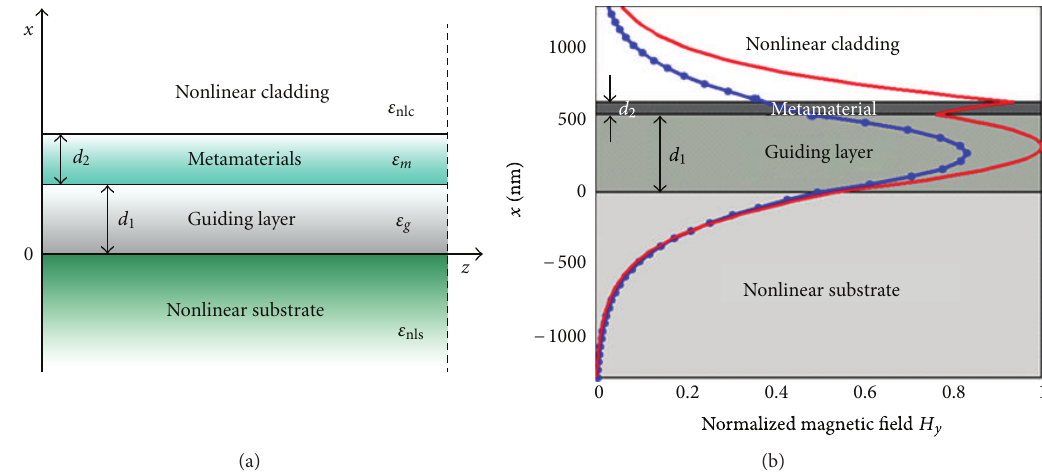
Figure 3: (a) Schematic diagram of a cross-sectional view of the nonlinear planar waveguide sensor with a metamaterial layer. 𝑑 1 = 500 nm, = 2 , 𝜀 = 2.2 , 𝜀 = 4 , 𝜀 = −2 , 𝑑 = 80 nm, 𝑛 = −0.6 , and 𝜆 = 1550 nm. (b) Normalized magnetic field 𝐻 𝜀 𝑐 𝑠 𝑔 𝑚 2 𝑥 -direction of the nonlinear planar waveguide sensor without (dotted blue line) and with the metamaterial layer (solid red line) [20].